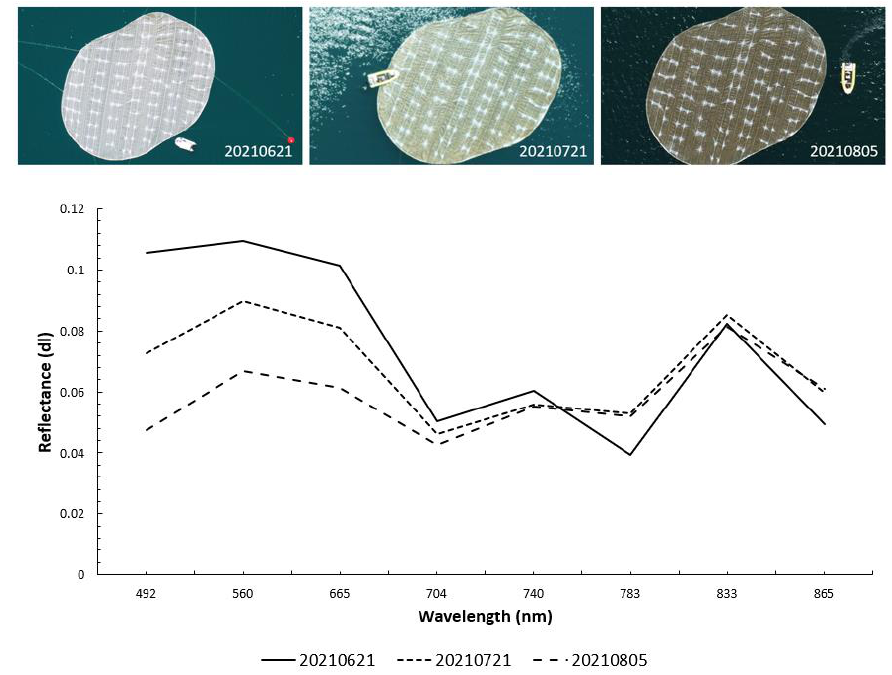
Figure 7. Spectral plot showing biofouling effects on HDPE mesh spectrum. Top: UAV images of the HDPE target showing the increase in biofouling accumulations. Bottom: HDPE mesh target central pixel plots for three dates. The 20210621 acquisition has no biofouling accumulations; 20210721 has moderate biofouling accumulations; 20210805 has dense biofouling accumulations. Note that no pixel averaging or background subtraction has been performed, and hence the 20 m bands are distorted and not representative of the HDPE